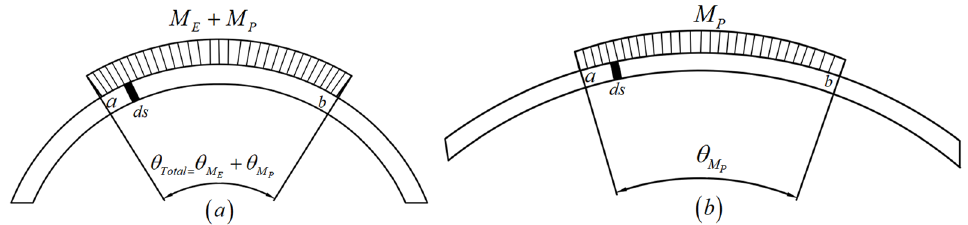
Figure 10. Schematic diagram of a sheet ( a ) after bending and before springback and ( b ) after springback.